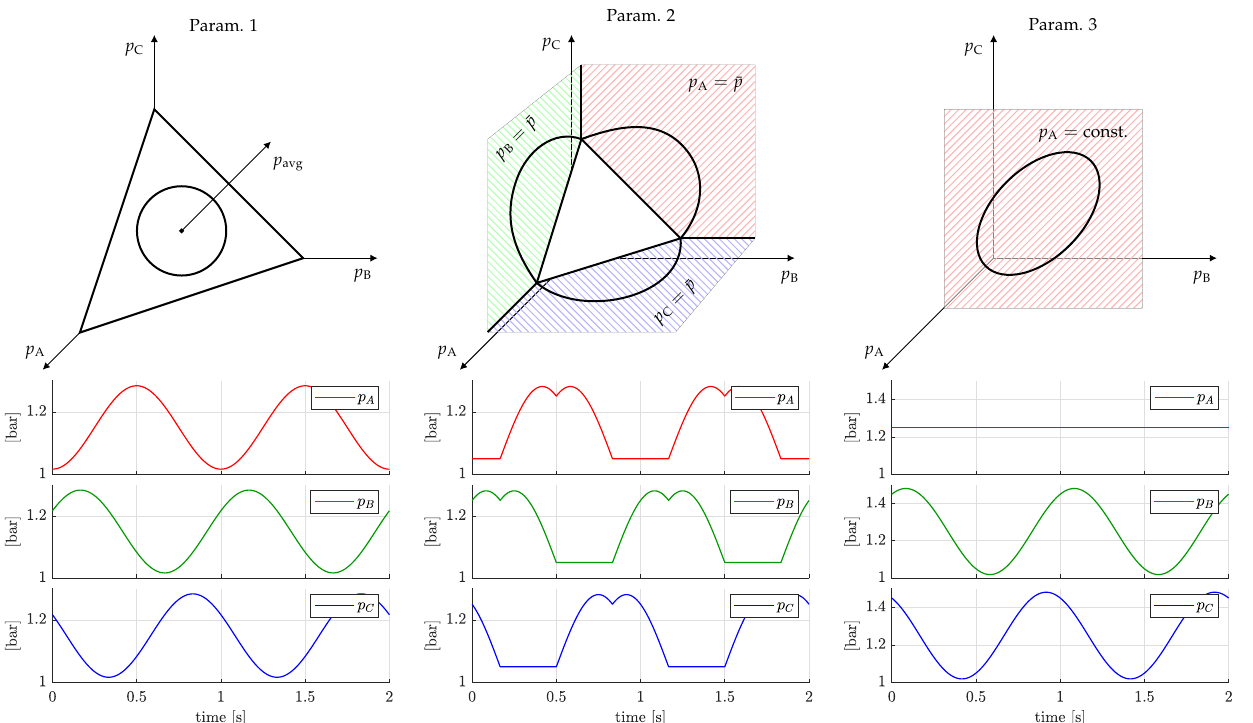
Figure 9. Visualization of the three virtual control input parametrizations: The first column shows parametrization 1 with the average actuator pressure used as the third virtual control input, the second column shows parametrization 2 with the lower actuator pressure level as third virtual control input (as used in this work) and the right column shows parametrization 3, where p A is directly used as the third virtual control input. The periodic input signal in ∆ p α and ∆ p β is indicated for parametrization 1 by the black circle in the pressure space. The virtual control input, p avg = 1.15bar, is a measure of the distance between the ∆ p α - ∆ p β -plane containing the circle and the origin. The resulting actuator pressures are shown in the bottom plot and it can clearly be seen that the resulting signals are periodic and of equal magnitude with a shifted phase. For parametrization 2, the resulting curves in the pressure space are given by the black curves (section of an ellipse), lying on the three colored planes that are offset to the origin by ¯ p = 1.05bar. They result from projecting the circle of the input signals, ∆ p α and ∆ p β , onto the three planes. The three actuator pressures in the bottom plot are also periodic signals with equal magnitude and a shift in phase. For parametrization 3, the curve in the pressure space is obtained by constraining the circle in ∆ p α and ∆ p β to the plane p A = 1.25bar, resulting in an elliptical curve. The corresponding actuator pressures are all periodic signals, but only p B and p C have equal magnitude. Hence, this virtual control input parametrization differs qualitatively from parametrizations 1 and